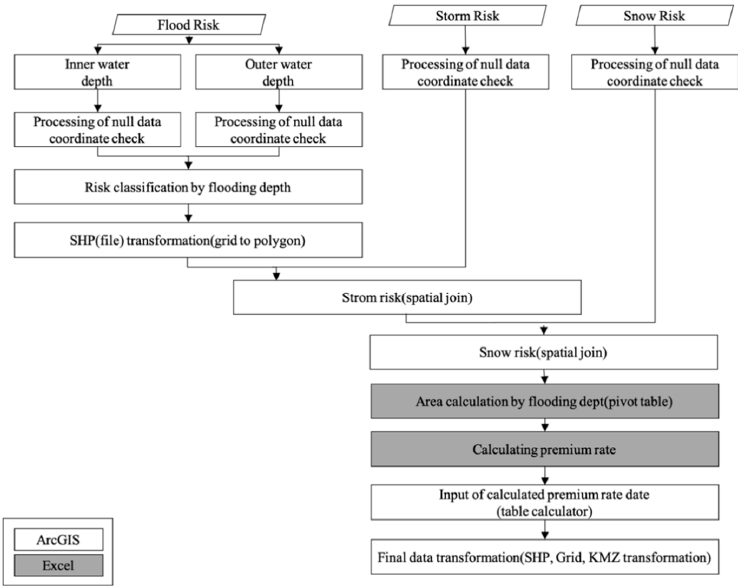
Figure 4. Flowchart for generating insurance management map.